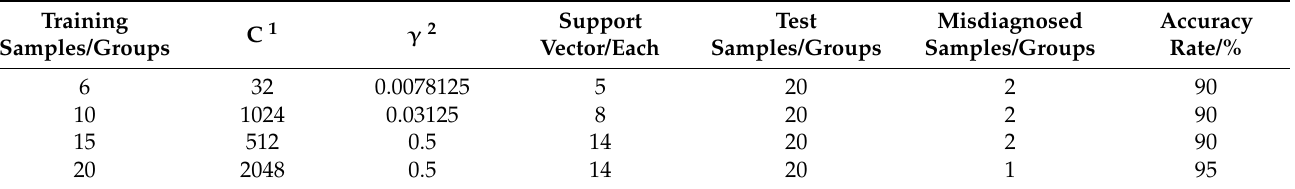
Table 6. Diagnostic results of leakage faults in hydraulic cylinder working circuit of different size training